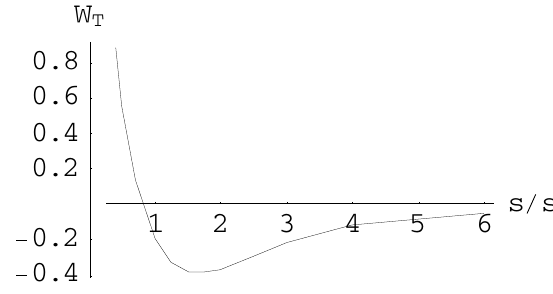
FIG. 5. The function W